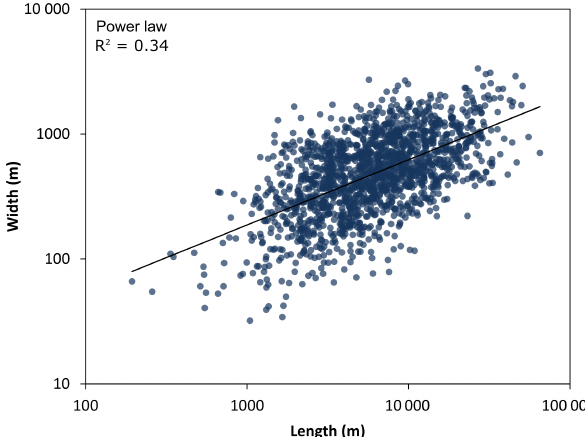
Figure 7. Relationship between tunnel valley length and average width (for single thread valleys with a confidence level of 1 and 2, N = 1135). Note, there is a tendency for longer tunnel valleys to be